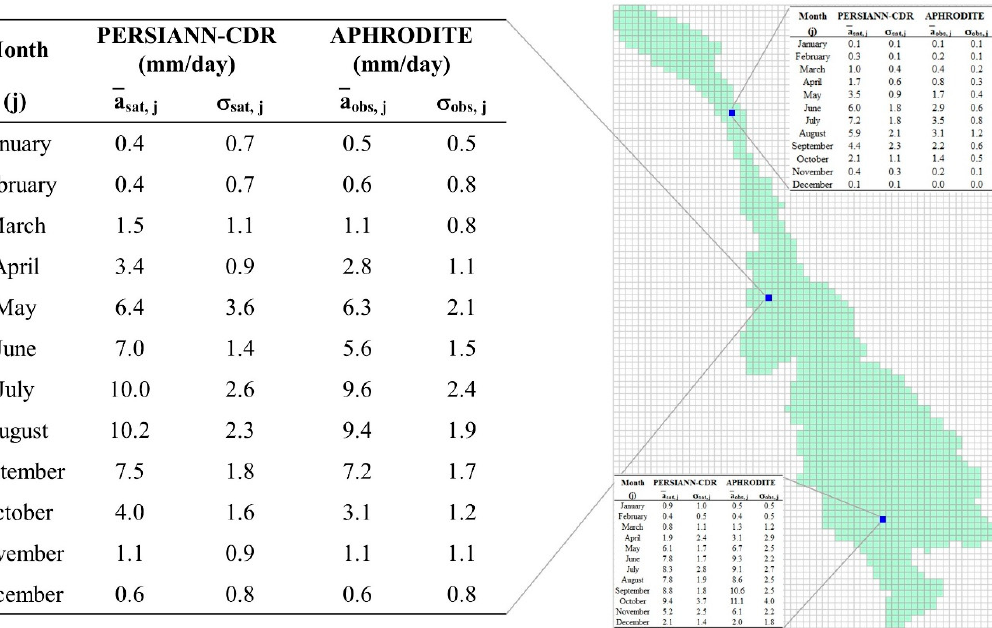
Figure 7. Statistical properties of a grid cell in the Mekong basin.